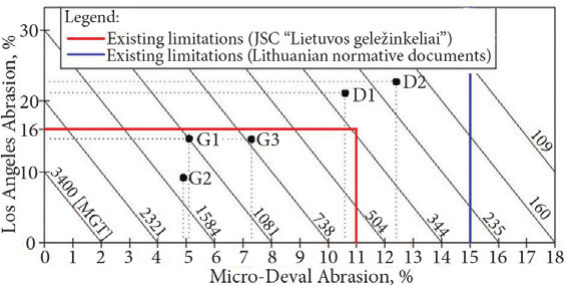
Fig. 4. Lifespan prognostic graphic model of ballast aggregate as sleepers are made of wood